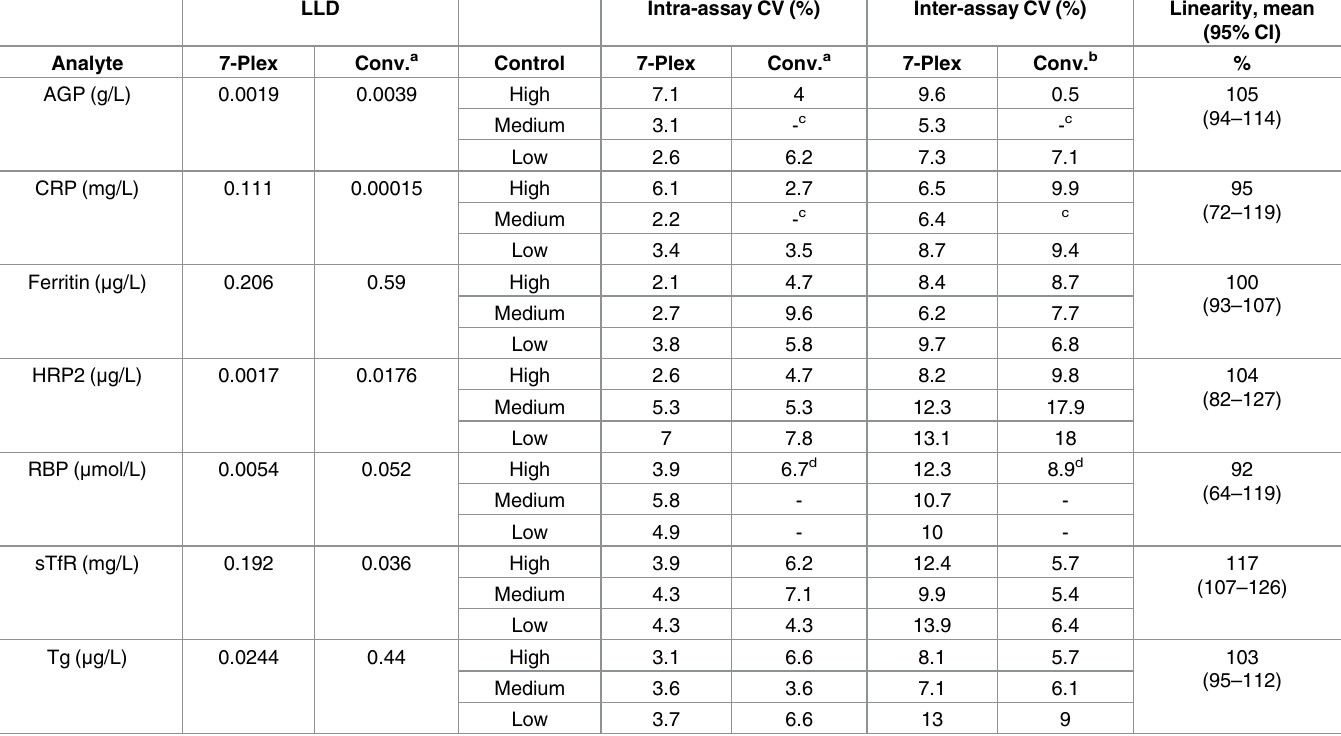
Table 1. Assaylower limits of detection (LLD), precision, and assaylinearity for 7-Plex and conventional ELISAs.